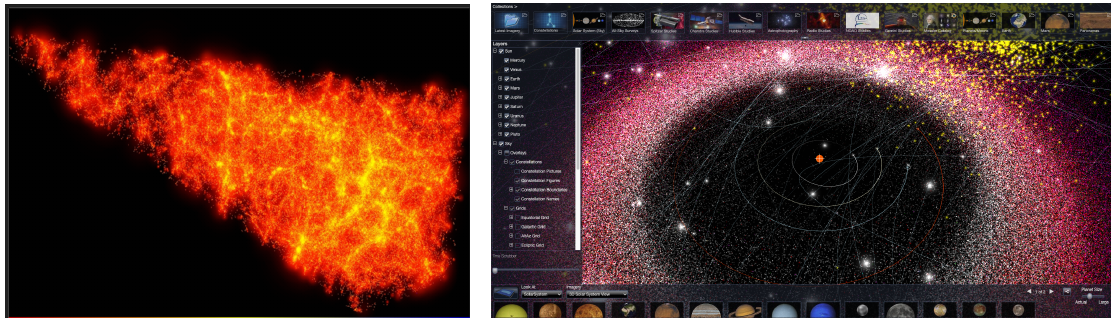
Figure 10. Left: Showing a lightcone visualized by Dykes et al. [134] with spectral energy distribution, where size and intensity are scaled by the stellar mass of the the full volume of 136,298 galaxies interactively at >30 FPS for visual emphasis. Right: Screenshot of the user interface from the World Wide Telescope at http://worldwidetelescope.org/webclient/ with images of our solar system and the sun in the center. The user can interactively explore the sky with different modes and telescope imagery in a 3D environment. Planets from our solar system are rendered with WebGL.